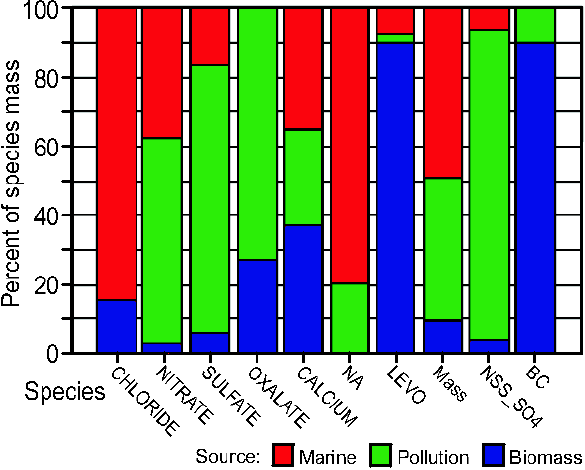
Fig. 3. Source profiles for the three sources identified by the PMF model for the CARMA-III (2005) data